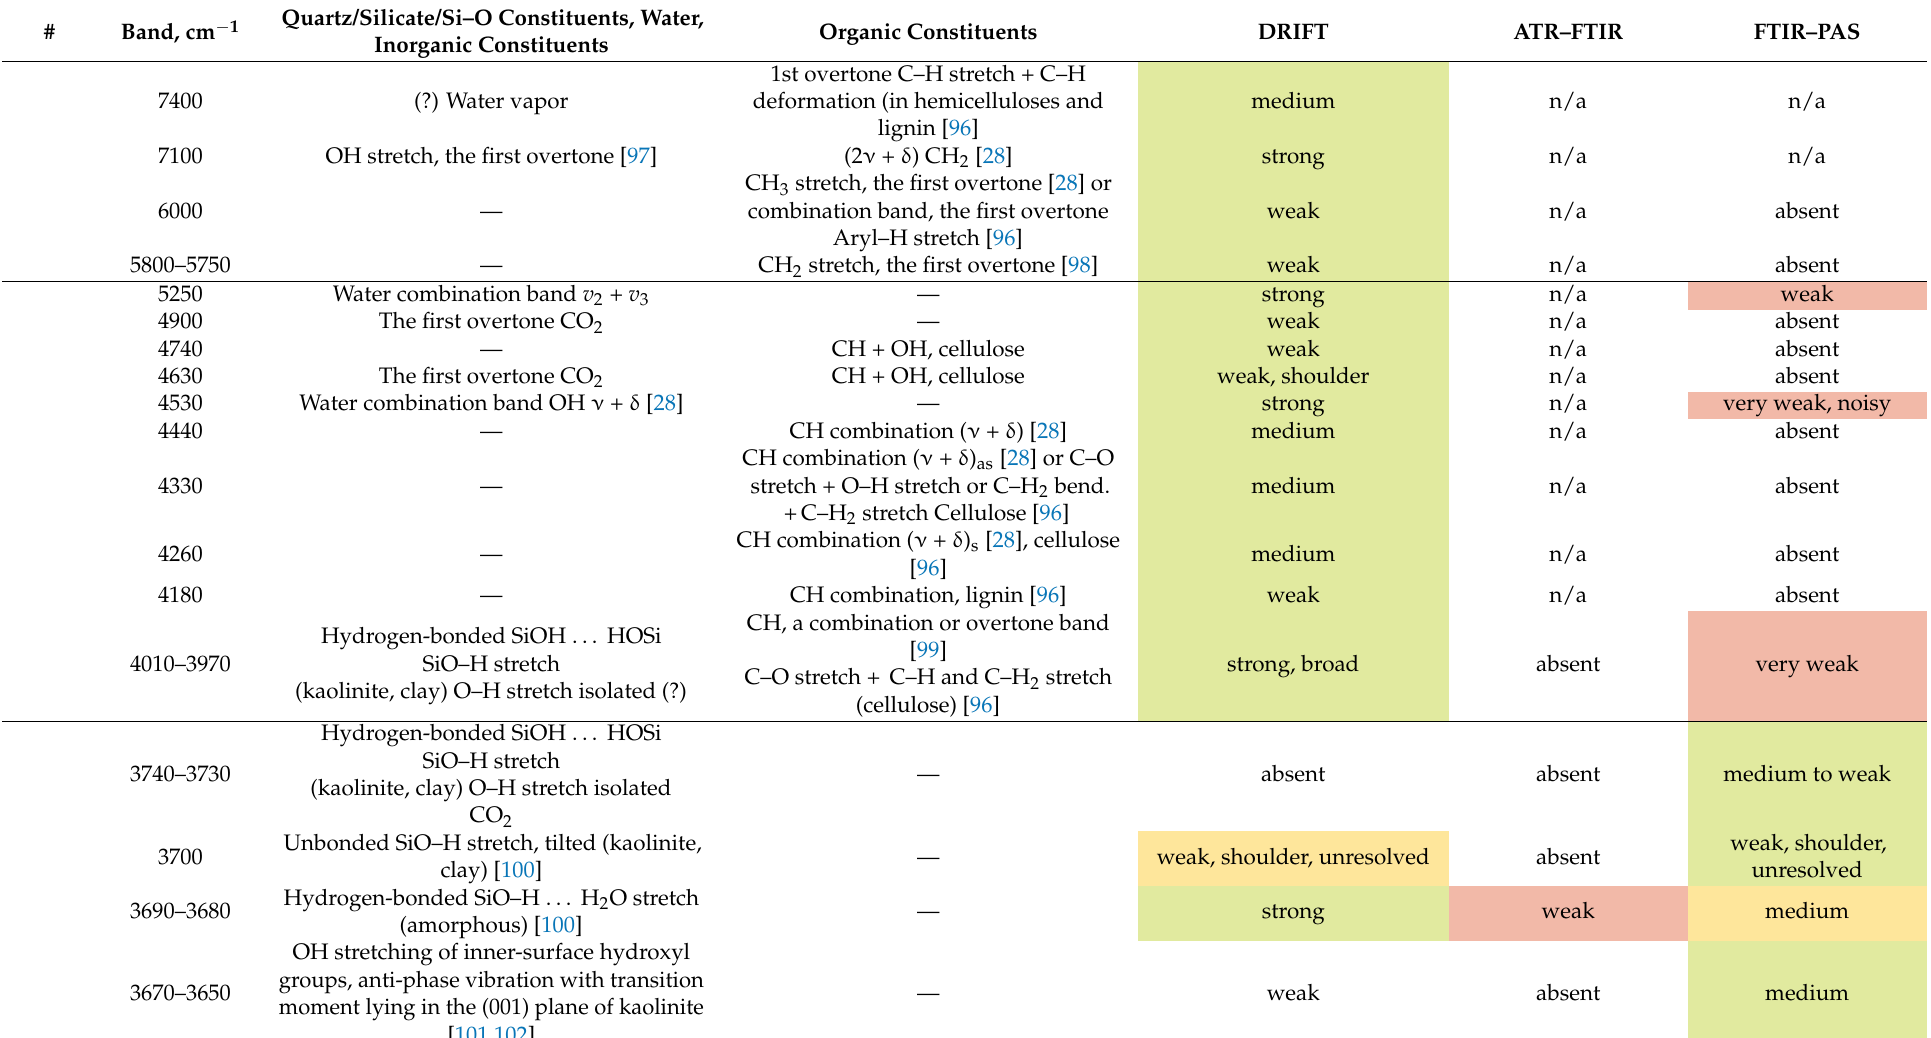
Table 1. Band assignments for silicate-based soils (chernozem and agrosod-podzolic soils and size